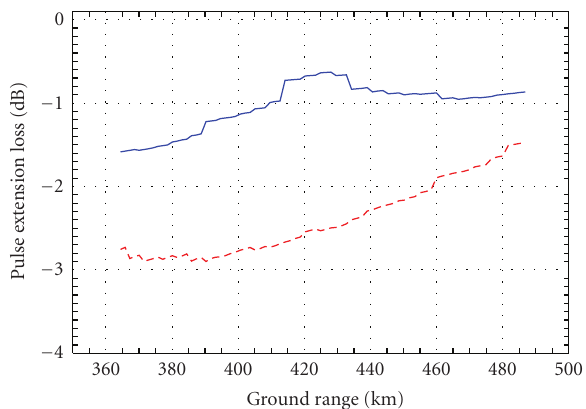
Figure 20: The pulse extension loss of the reflector system versus ground range with four (solid line) and two (dotted line) active